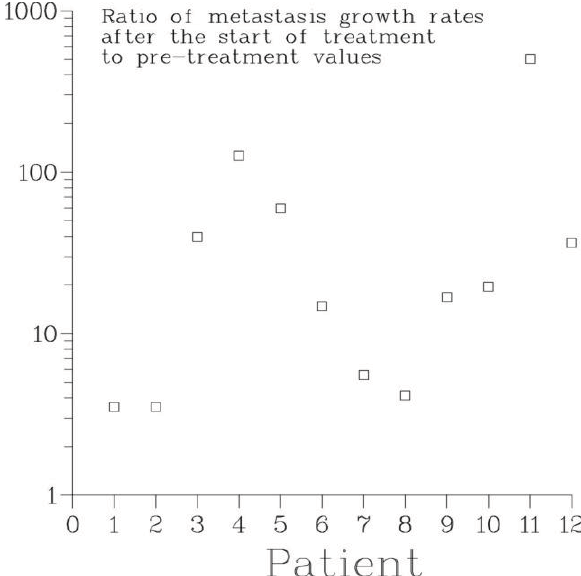
/γ of the rates of growth of bone metastases after the start 1 0